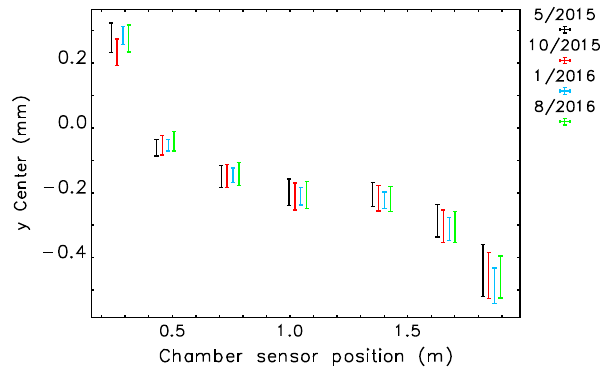
FIG. 15. Measuredverticalpositionofthevacuumchamberinside the cryostat over a one-year period using the beam-based method. SCU1 reaches the return pressure after about 30 min. After a quench, the magnet temperatures recover on a shorter time scale (i.e., a few minutes), as discussed below. The average beam recovery time is 20 – 30 min.